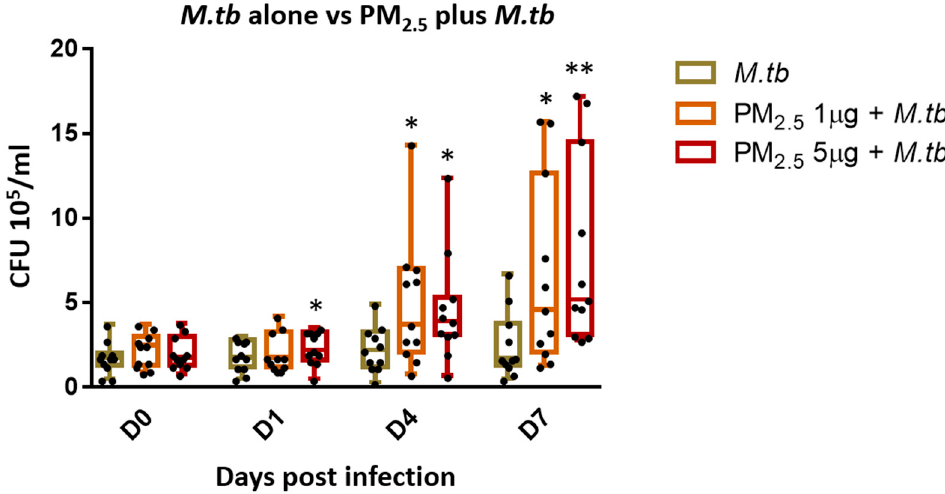
Figure 3. PM 2.5 exposure causes loss of intracellular growth control of M.tb by PBMC. PBMC from 11 study subjects were pre-exposed to PM 2.5 (final concentrations of 0, 1, and 5 µ g / mL) for 20 h followed by infection with M.tb MOI 1 for 0 (2 h), 1, 4, and 7 days. CFU assays were performed to determine the effects of PM 2.5 exposure on M.tb growth control of PBMC. CFU numbers from 11 independent experiments are expressed as 5/95 percentile box-and-whiskers where the center represents the 50 th percentile, the upper hinge the 75 th percentile, and the lower hinge the 25 th percentile. Statistically